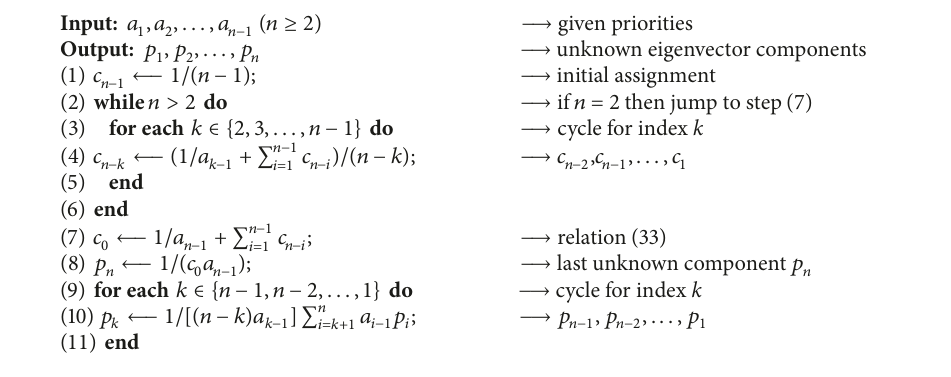
Algorithm 1: Calculation of eigenvector components.